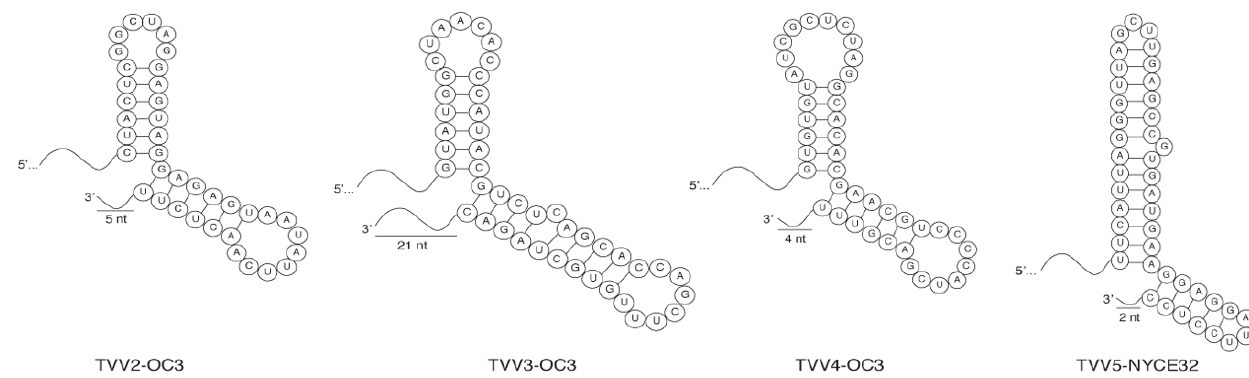
Figure 4. Double stem–loop structures near the coding-strand 3’ termini of TVV2 through TVV5 strains. Secondary-structure predictions identified this conserved feature, shown here for repre- sentative strains TVV2-OC3, TVV3-OC3, TVV4-OC3, and TVV5-NYCE32. This feature extends to within 21 nt of the coding-strand 3’ terminus of each virus and consists of two adjoining stem–loops with no intervening nt